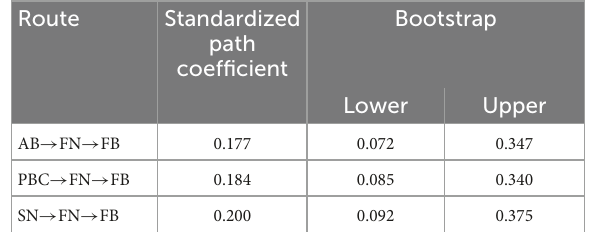
TABLE 8 Mediating effect test results.